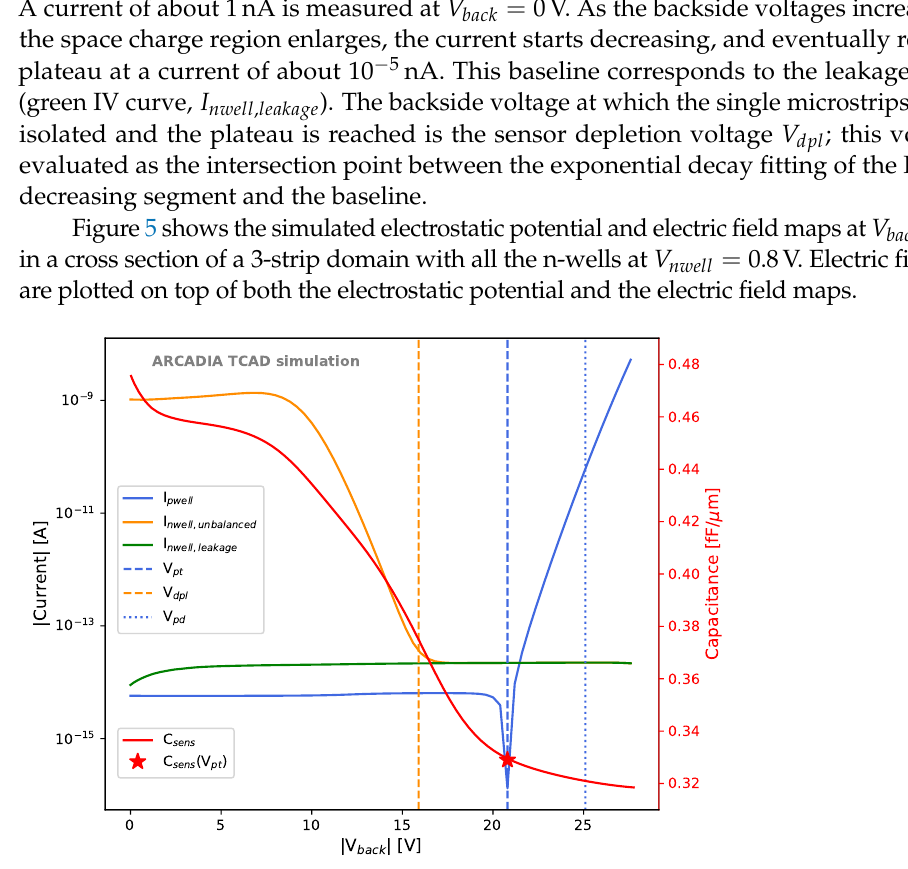
Figure 4. Example characteristic IV and CV curves extracted from TCAD simulations of ARCADIA monolithic sensors. The red vertical axis refer to the sensor capacitance ( C sens ) CV curve.